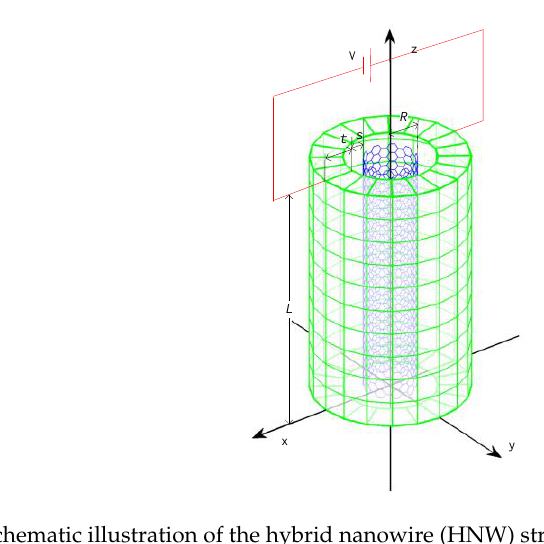
Figure 1. Schematic illustration of the hybrid nanowire (HNW) structure where a single-wall carbon nanotube (SWCNT) of radius R is coated by a cylindrical layer of ZnO of thickness t . The SWCNT and ZnO layer are bonded via the van der Waals (vdW) interaction with equilibrium interspacing s .